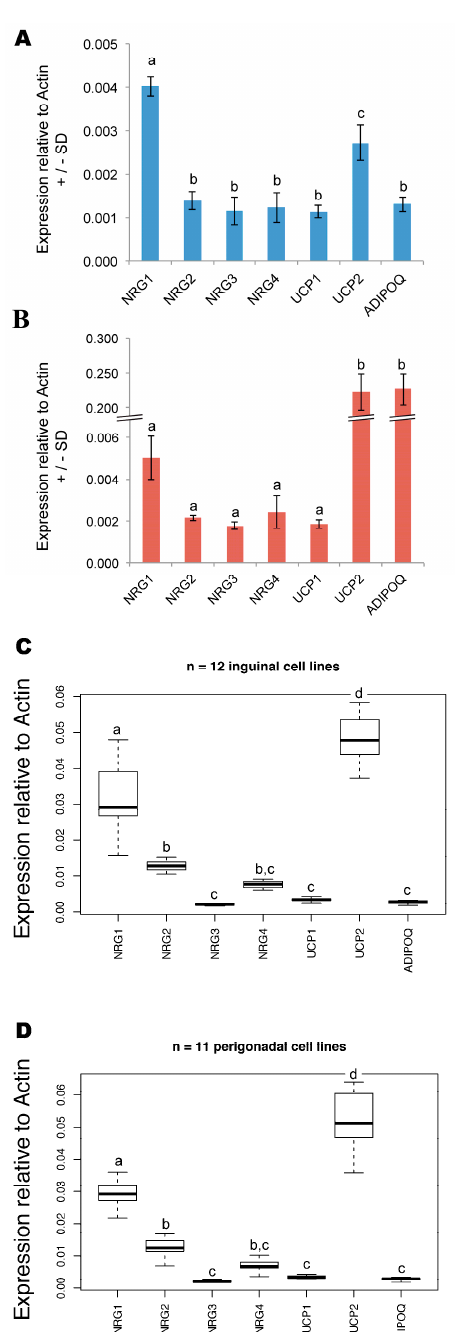
Figure 1. Expression of NRG1-4 and markers of brown (BAT) or white adipose tissue (WAT) in human and murine primary stem cells. ( A ) Data from human primary AF2 stem cells (ASCs). Statistical significance measured by 1-way ANOVA and Tukey's HSD post-hoc test. One-way ANOVA test statistics follow. For gene: df = 6, SS = 2.198e-05, MS = 3.664e-06; for residuals, df = 14, SS = 1.049e-06, MS = 7.500e-08. F = 48.89 and Pr(>F) <1.35e-08. By Tukey’s HSD post-hoc test, NRG1 is significantly different ( p < 0.001) from all other genes. Statistical groups are indicated by lowercase letters (a, b, c), and all differ at the p < 0.001 level. ( B ) Data from human primary adipose-differentiated AF2 cells. Statistical significance measured by 1-way ANOVA and Tukey's HSD post-hoc test. One-way ANOVA test statistics follow. For gene: df = 6, SS = 0.2107, MS = 0.03512; for residuals, df = 14, SS = 0.0024, MS = 0.00017. F = 205 and Pr (>F) < 8.08e-13. By Tukey’s HSD post-hoc test, only UCP2 and ADIPOQ are significantly different ( p < 0.001) from all other genes. Statistical groups are indicated by lowercase letters (a and b), and differ at the p < 0.001 level.